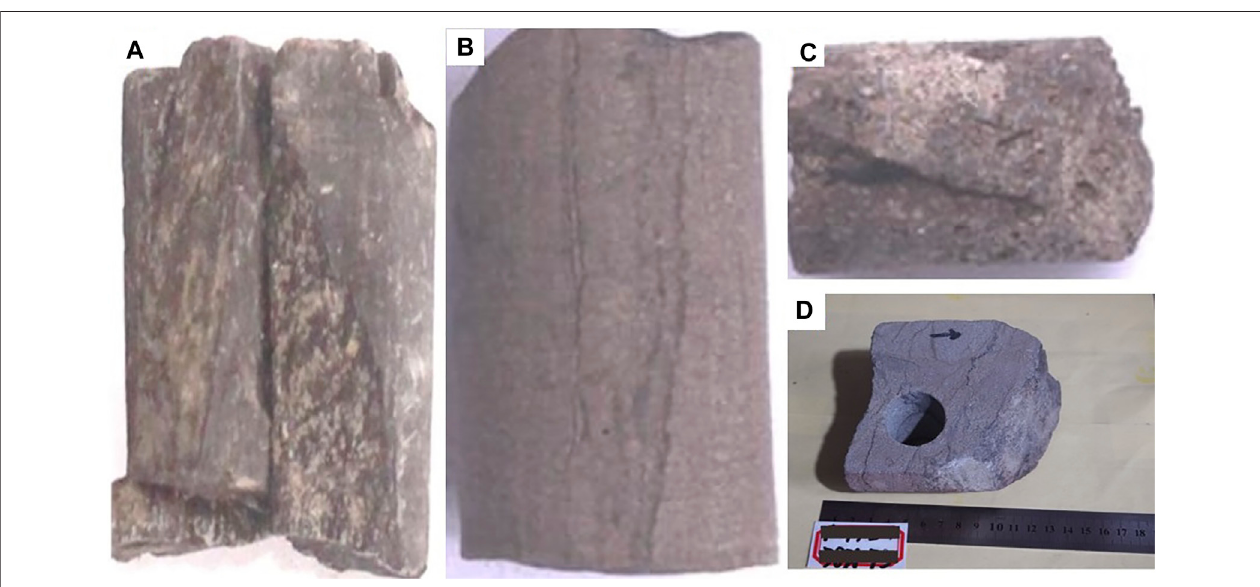
FIGURE 6 | Fractures in the cores of low-permeability sandstone reservoirs in the LD-A gas fi eld. (A) natural fracture in well LD-A-1-6, depth 4,093.80 m, (B) low- angle shear fracture in well LD-A-1-5, depth 4,000.40 m, (C) low-angle tension fractures in well LD-A-1-5, depth 4,031.70 m, and (D) diagenetic fractures in well LD-A- 2-1, depth 3,882.70